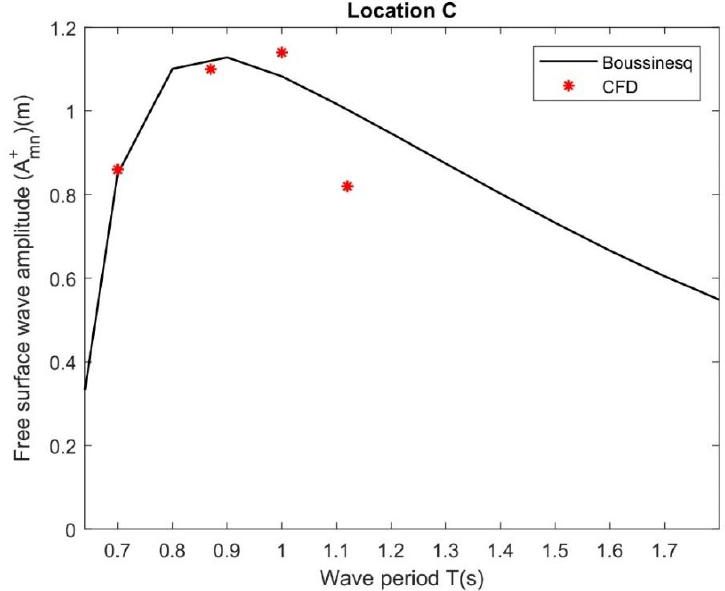
Figure 14. Comparison of Boussinesq, second-order super-harmonic wave amplitude A + mn in Equation (29) and CFD models of free surface elevation for location B.